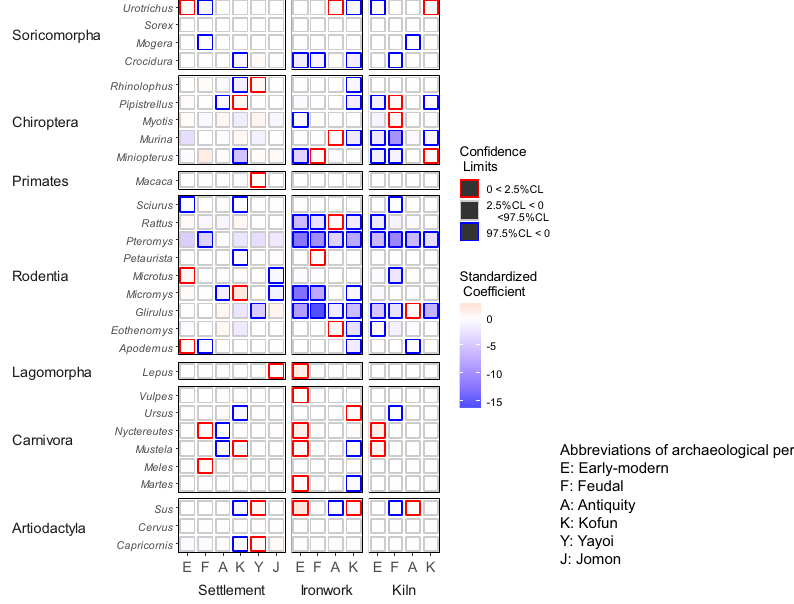
Figure 1. Tile chart of standardised coefficients of archaeological factors (posterior mean) and 95% credible limits for genera included in the analysis.